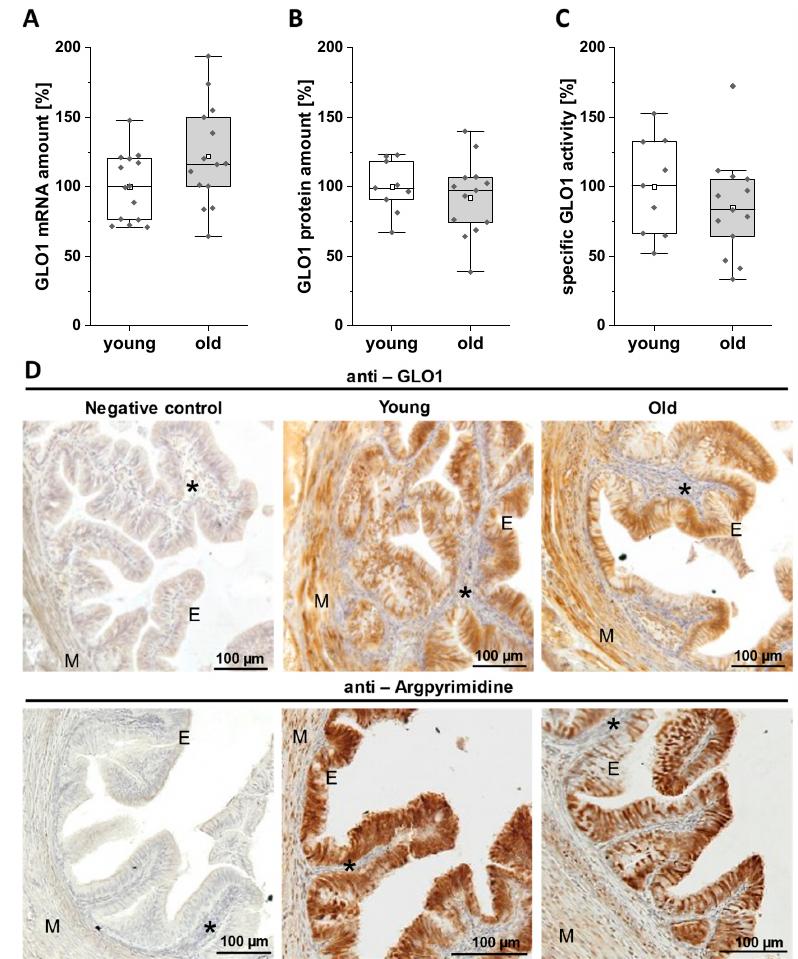
Figure 3. Quantification of GLO1 mRNA, protein and enzymatic activity in the oviduct of young and old rabbits at day 6 p.c. ( A ) GLO1 mRNA levels were analysed by qPCR. ( B ) GLO1 protein analysis was carried out by Simple Western method. Vinculin was used for normalisation to calculate relative mRNA and protein amounts. ( C ) Enzymatic GLO1 activity was measured spectrophotometrically in 10 µg oviductal protein. Specific GLO1 activity was calculated relatively to GLO1 protein amount within the same sample. Results are shown as box plots. All values are expressed in per cent, with young = 100% ( n ≥ 9). ( D ) Immunohistochemical analysis of GLO1 and argpyrimidine in cross-sections through the oviduct. M = Muscularis. * = Mucosa layer with (ciliated) columnar epithelium (E).